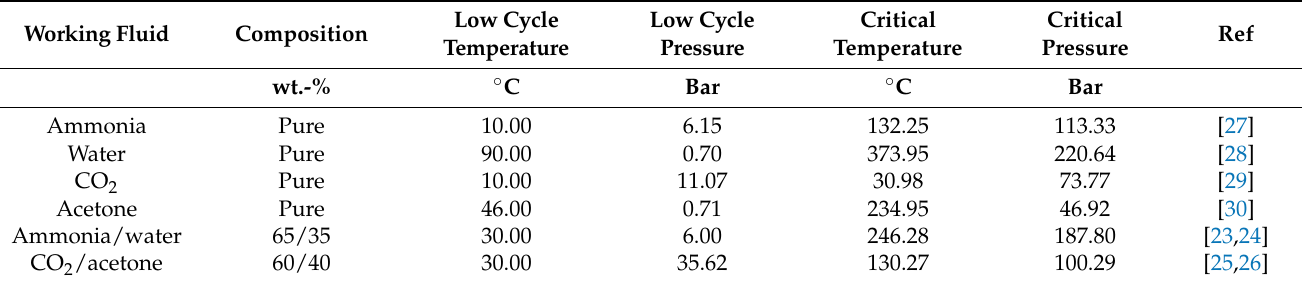
Table 1. Operational and critical data of the working fluids used in this study.